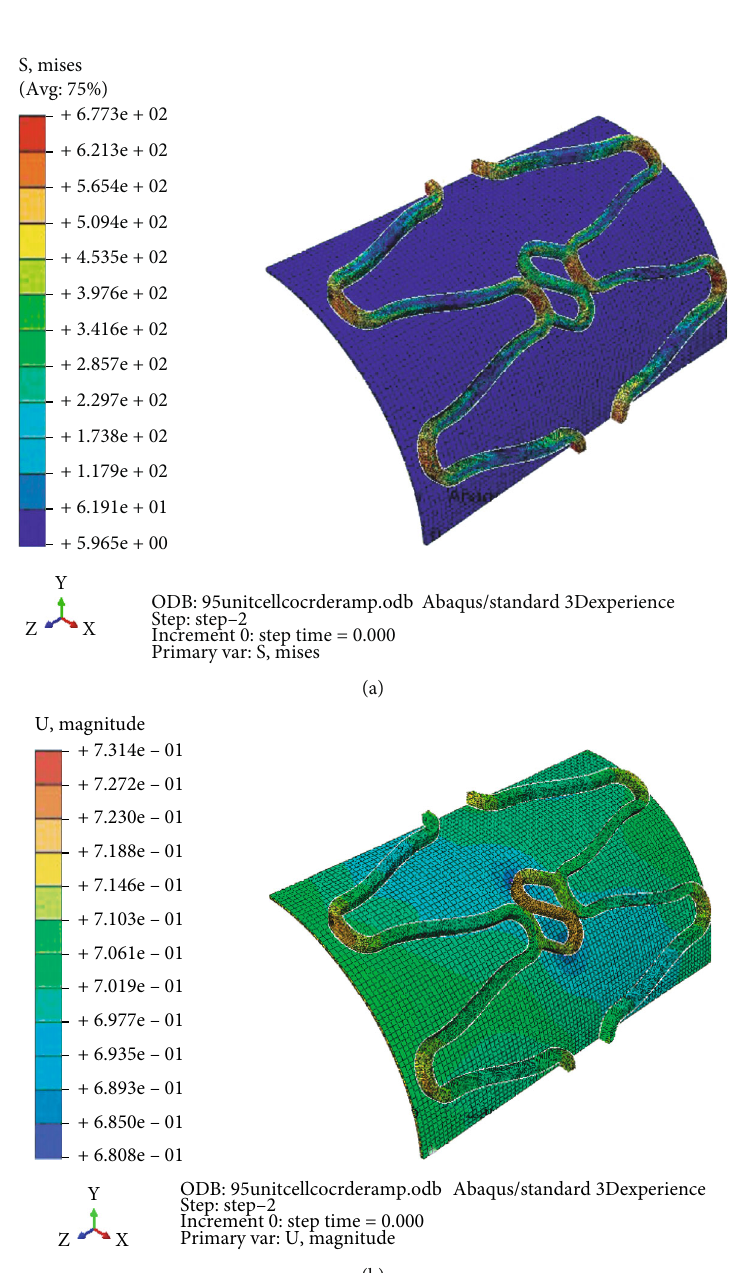
Figure 12: (a) Model A: stress distribution before de fl ation. (b) Model A: strain distribution before de fl